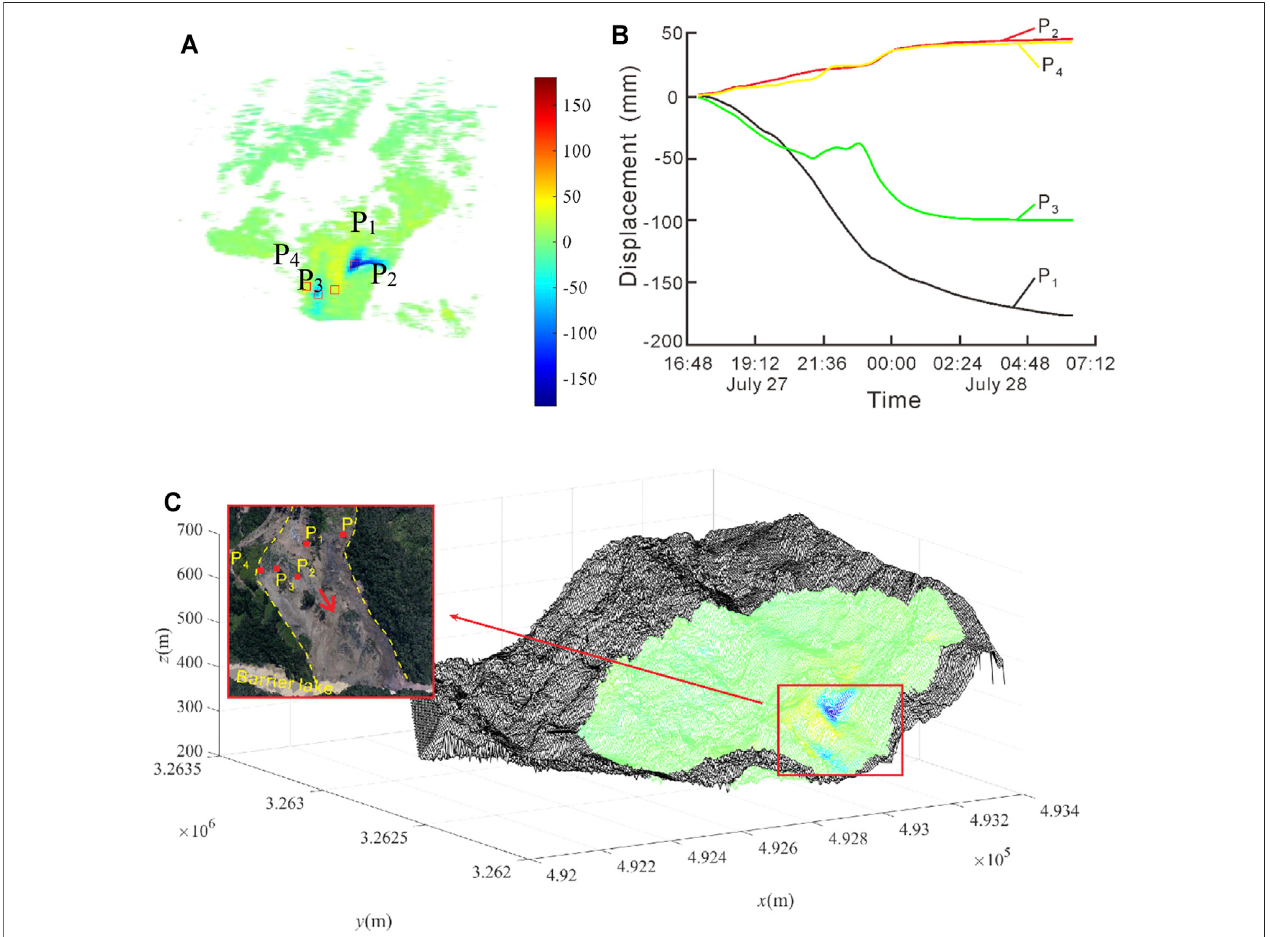
FIGURE 10 | Deformation of the Zhongbao landslide during July 27 – 28. (A) Accumulative displacement of the landslide surface; (B) the displacements of monitoring points vise time; (C) Three-dimensional topographic map. Note, the negative value of the displacement means that the point moves toward the Radar.